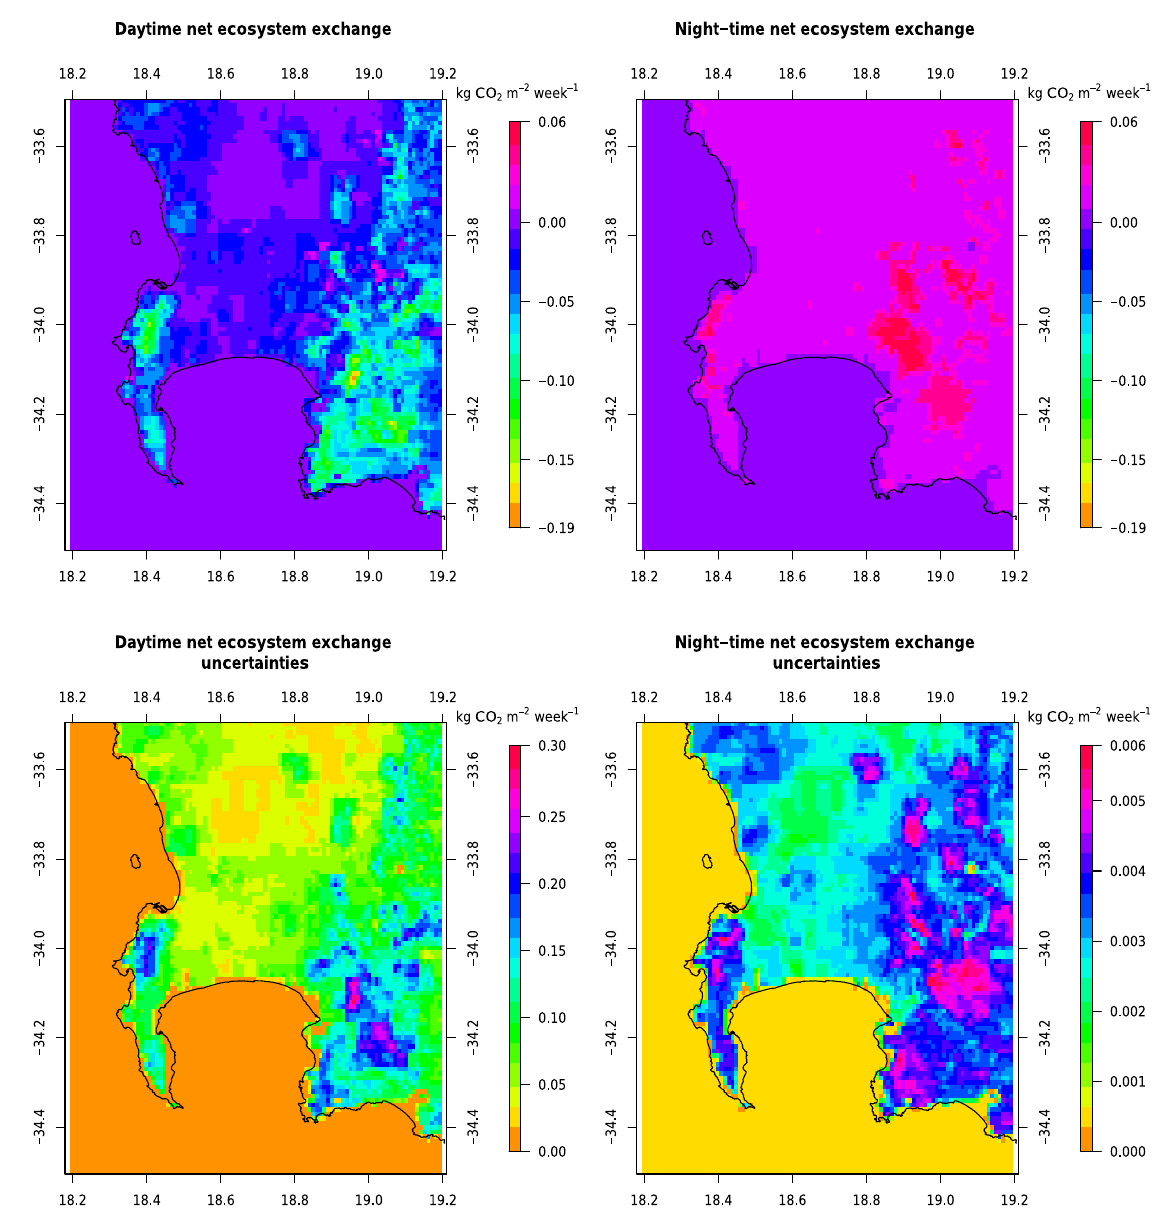
Figure 4. Prior estimates for day- and night-time NEE fluxes (kg CO 2 m − 2 week − 1 ) and the corresponding uncertainties, expressed as standard deviations (kg CO 2 m − 2 week − 1 ), during the month of March 2012. The prior estimates were obtained from the CABLE land– atmosphere exchange model at a spatial resolution of 1km × 1km. The extent of the grid is between 34.5 and 33 . 5 ◦ S and between 18.2 and 19.2 ◦